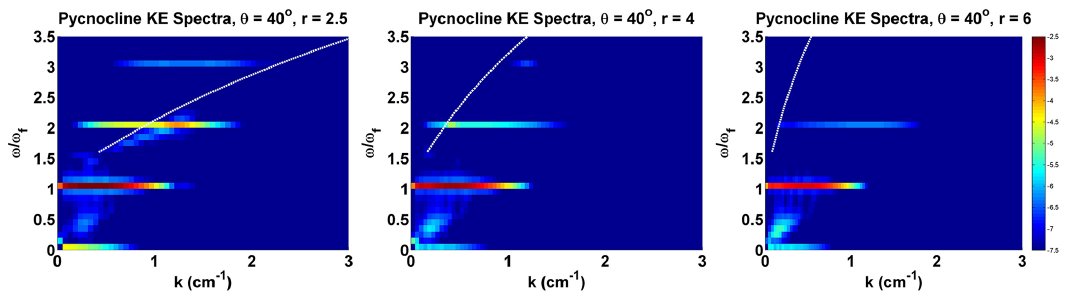
Figure 9. Kinetic energy spectra in the pycnocline for simulations with θ = 40 degrees and three values of r . The white line shows the dispersion curve for interfacial waves in each case.